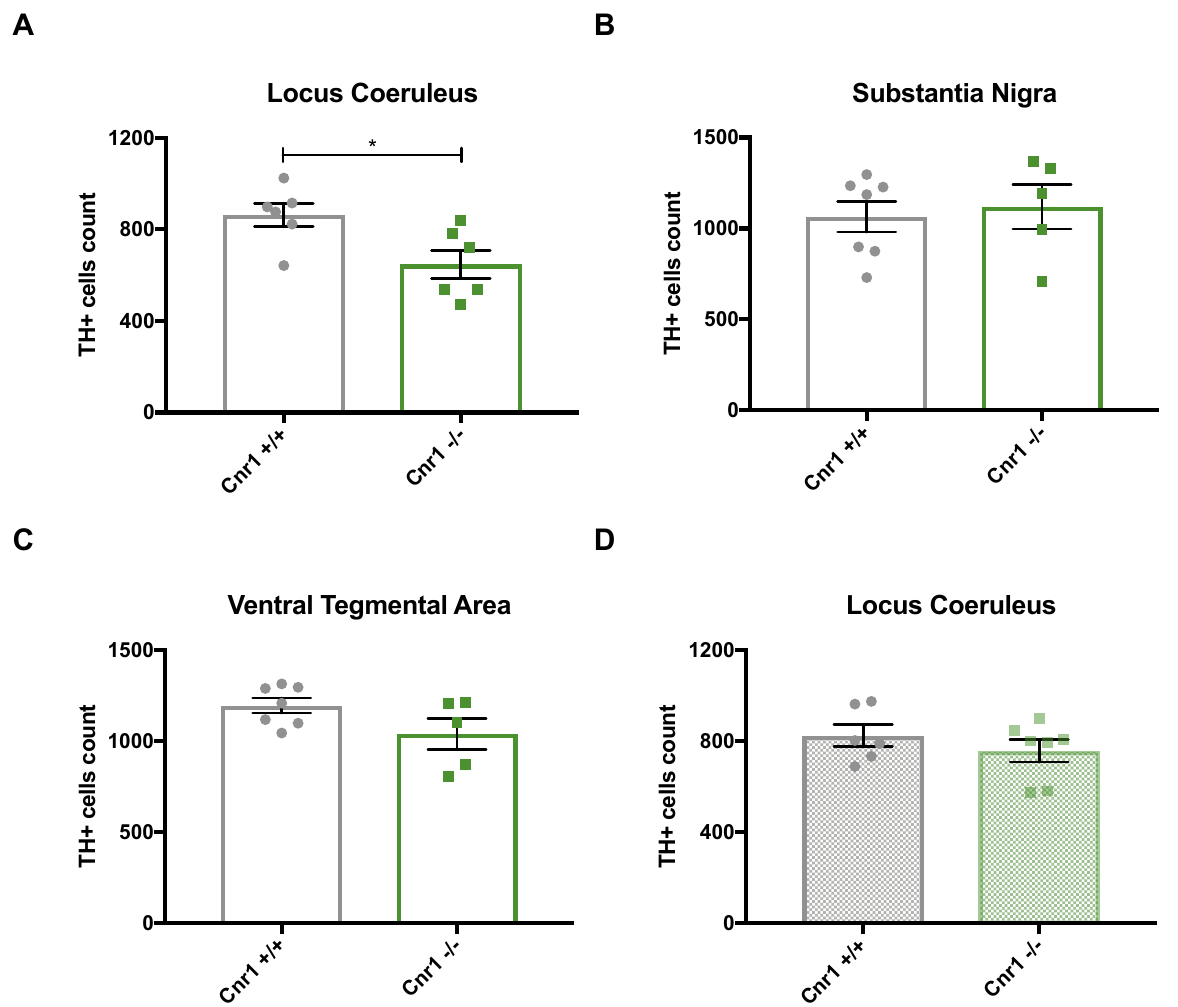
Figure 2. Quantitative stereological analysis of the total number of tyrosine hydroxylase (TH)-positive cells in 18-month-old Cnr1 +/+ wild-type and Cnr1 − / − animals within the ( A ) locus coeruleus, ( B ) substantia nigra, ( C ) ventral tegmental area and ( D ) in 3-month-old Cnr1 +/+ wild-type and Cnr1 − / − animals within the locus coeruleus.* p < 0.05 according to Student ´ s t -test ( n = 5–7 per genotype). Dots represent single animals, columns represent mean values, error bars represent standard error of means